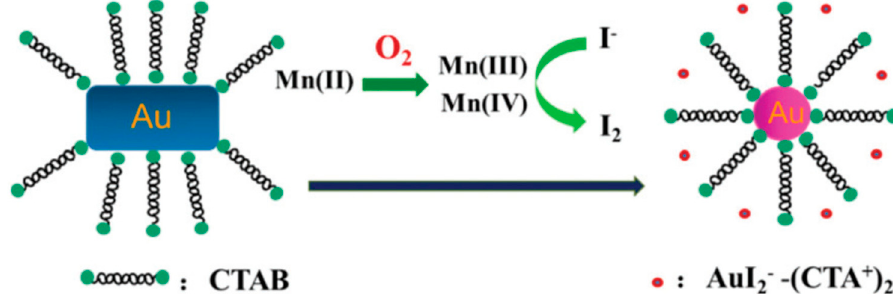
Figure 10. The schematic illustration for the detection of dissolved oxygen based on the iodine-mediated etching of AuNRs. Reproduced with permission from Reference [107]. Royal Society of Chemistry, 2016.